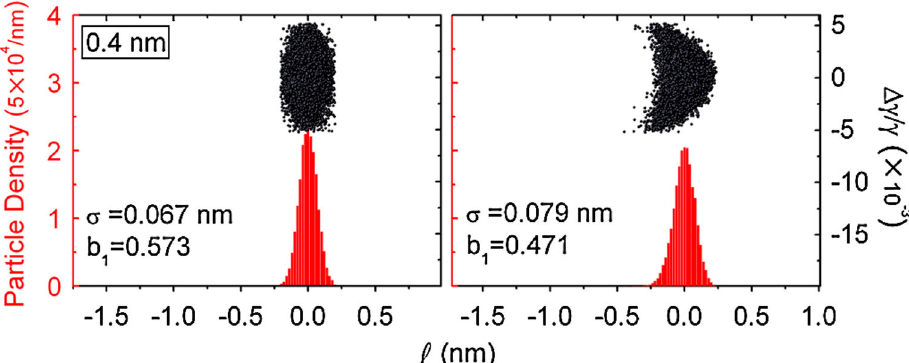
FIG. 12. (Color) Bunch expansion by the FCBS. A 0.4 nm ( 6 (cid:5) ) Gaussian bunch before (left) and after (right) the FCBS is shown. As can be seen by the (cid:5) values, there is only moderate expansion. The moon shaped distortion originates from a residual nonzero T 566